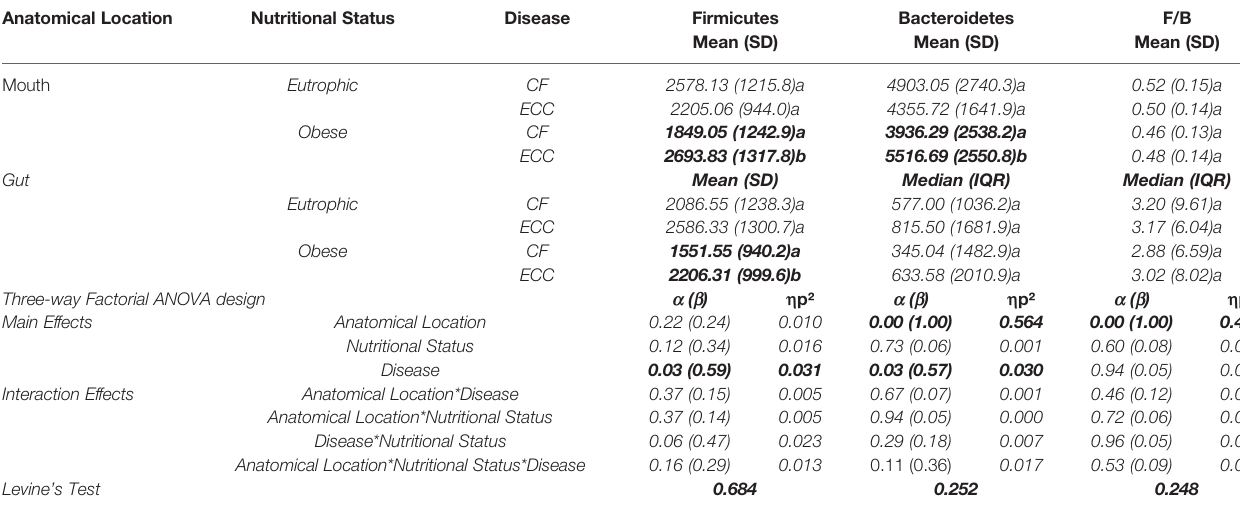
TABLE 1 | Interaction effect of nutritional status (eutrophic × obese) and disease (CF × ECC) on the Firmicutes and Bacteroidetes levels (ng/µL) in the mouth and gut. Anatomical